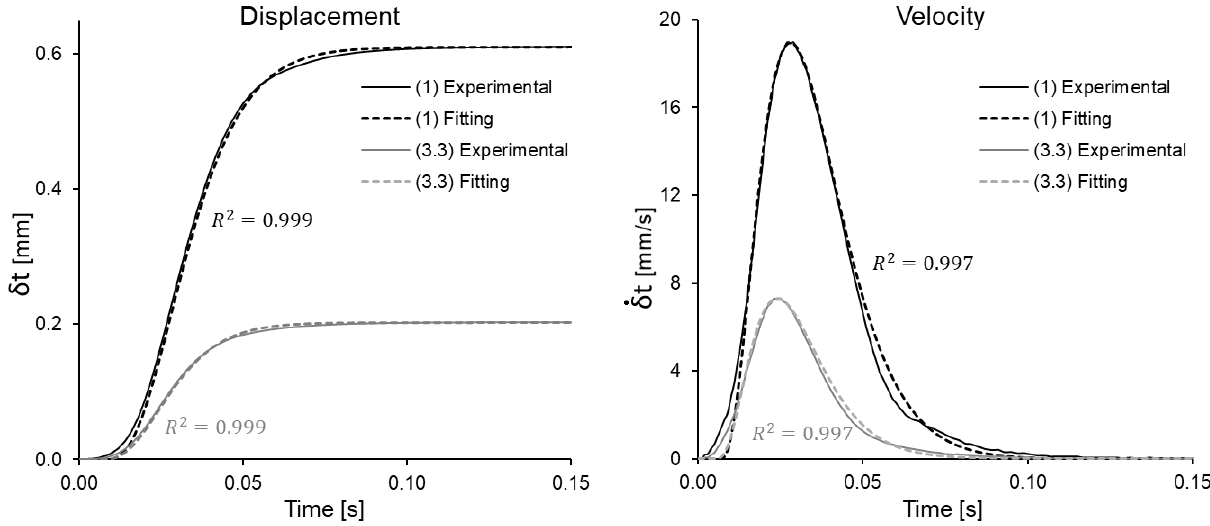
Figure 3. Experimental displacement and experimental velocity applied to a specimen, plotted together with the fit by gamma-type function. The plot also shows the derivatives in Sections 1 and 3. It can be seen that the fit is in both cases more extreme than